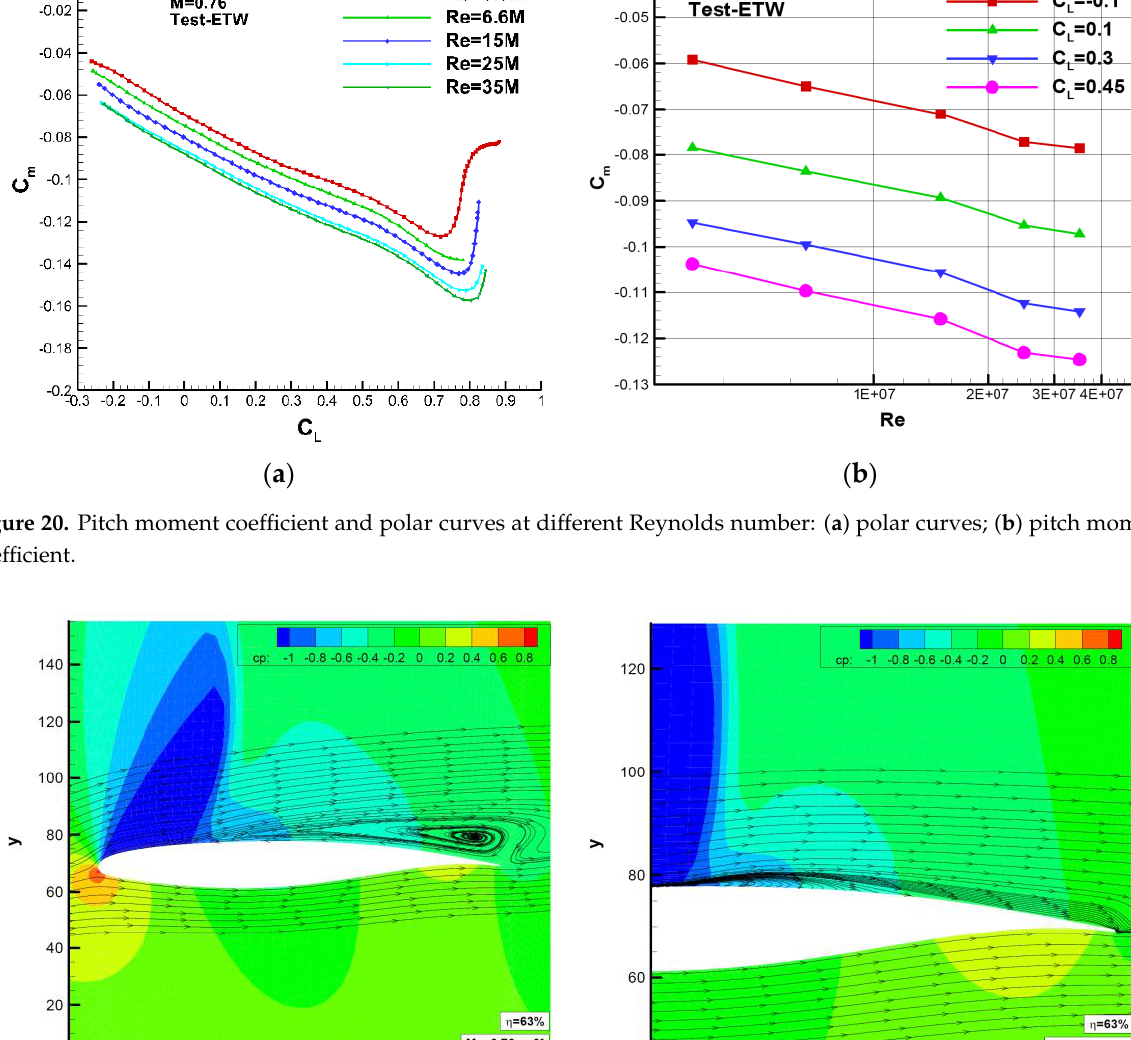
Figure 19. Increments of lift coefficient versus Reynolds number (M = 0.76): ( a ) α = 2°; ( b ) α = 4°.